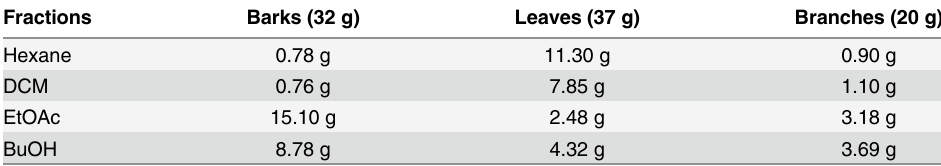
Table 1. Mass quantities of the fractions obtained from the partitioned ethanolic extract of Mimosa tenuiflora